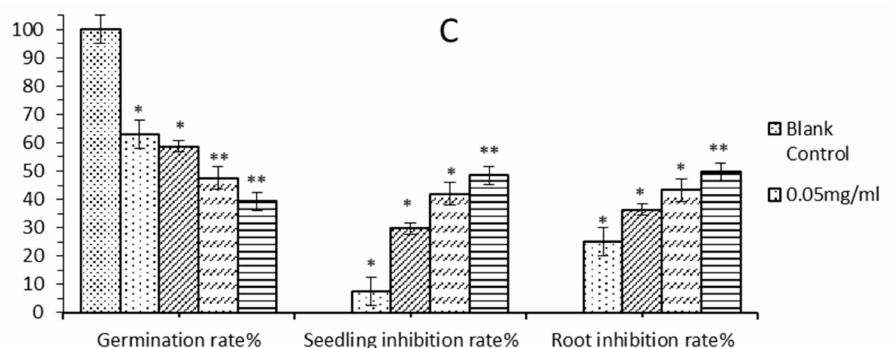
Figure 4. Allelopathic e ff ects of predicted active compounds in E. globulus leaves A is gallic acid, B is citric acid, and C is isopulegol. * represents a significant di ff erence between the experimental group and the control group (* p < 0.05, ** p <